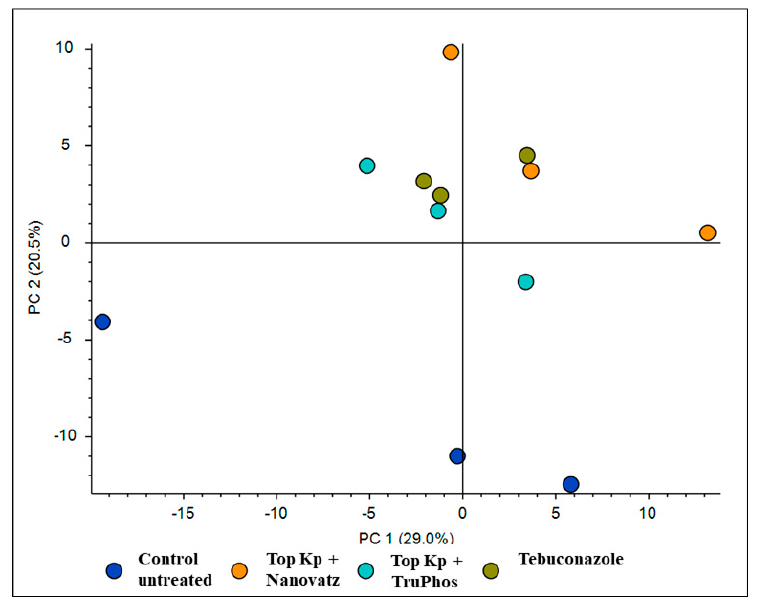
Figure 6. PCA analysis for 205 compounds identified by LC-MS/MS in cv. Carignan grape skin tissues treated with six foliar spays (starting at 6 April until 8 June) of the fungicide Folicur (tebuconazole) 0.02%, Top KP+ 1% plus Nanovatz 0.1%, or Top KP+ 1% plus TruPhos 0.25% and untreated grapes.